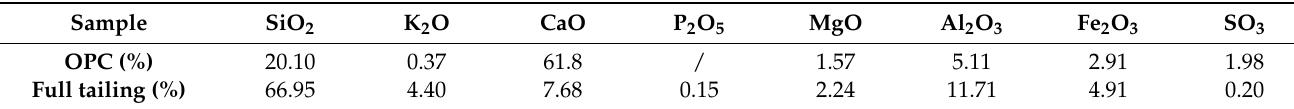
Figure 3. The PSD curves: ( a ) full tailings; ( b ) OPC. Table 1. Chemical composition of the raw materials.